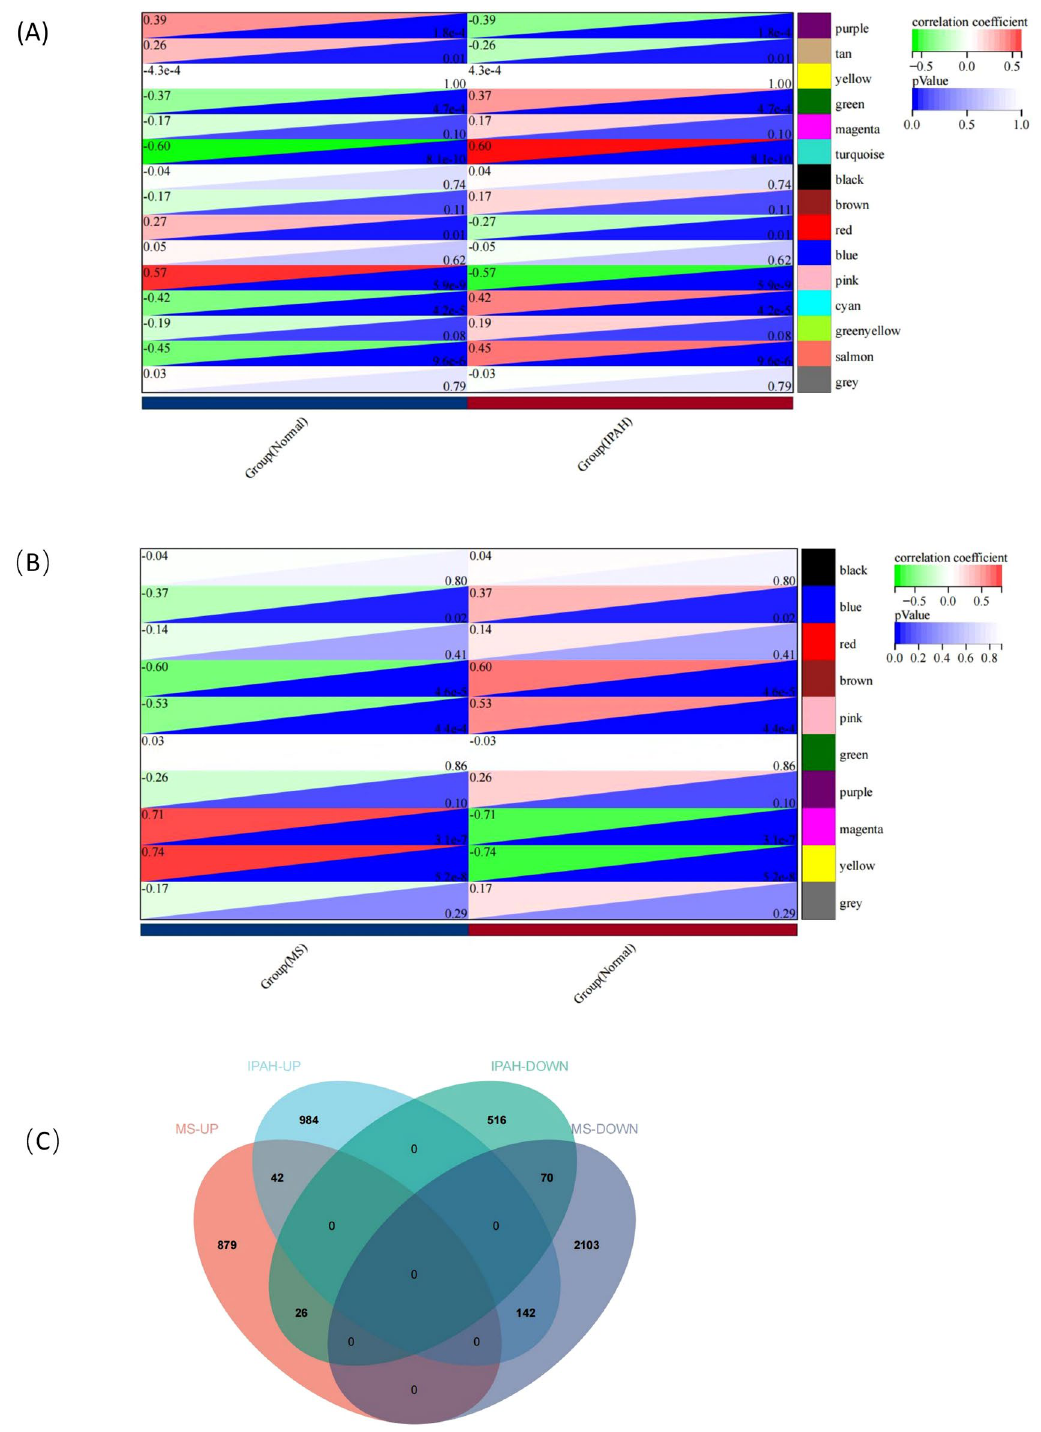
Figure 4. ( A ) Heat map of module correlation with IPAH. Turquoise 、 cyan 、 salmon modules had the strongest positive association with IPAH, pink and purple modules had the strongest negative correlation with IPAH. ( B ) Heat map of module correlation with MS. Magenta 、 yellow modules had the strongest positive association with MS, brown and pink Modules had the strongest negative correlation with MS. ( C ) Venn plot of overlapping module genes for IPAH and MS. Figure 4 is drawn by R software program (version 3.40.6; R Foundation for Statistical Computing, Vienna, Austria, https:// www.r- proje ct.